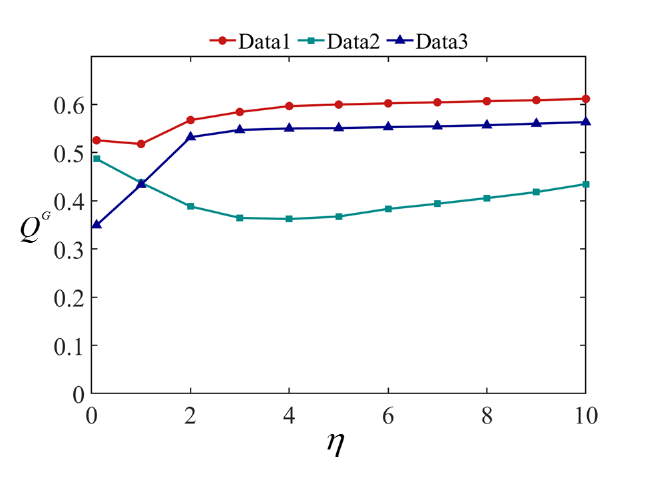
Figure 15. MI evaluation results at different η values.